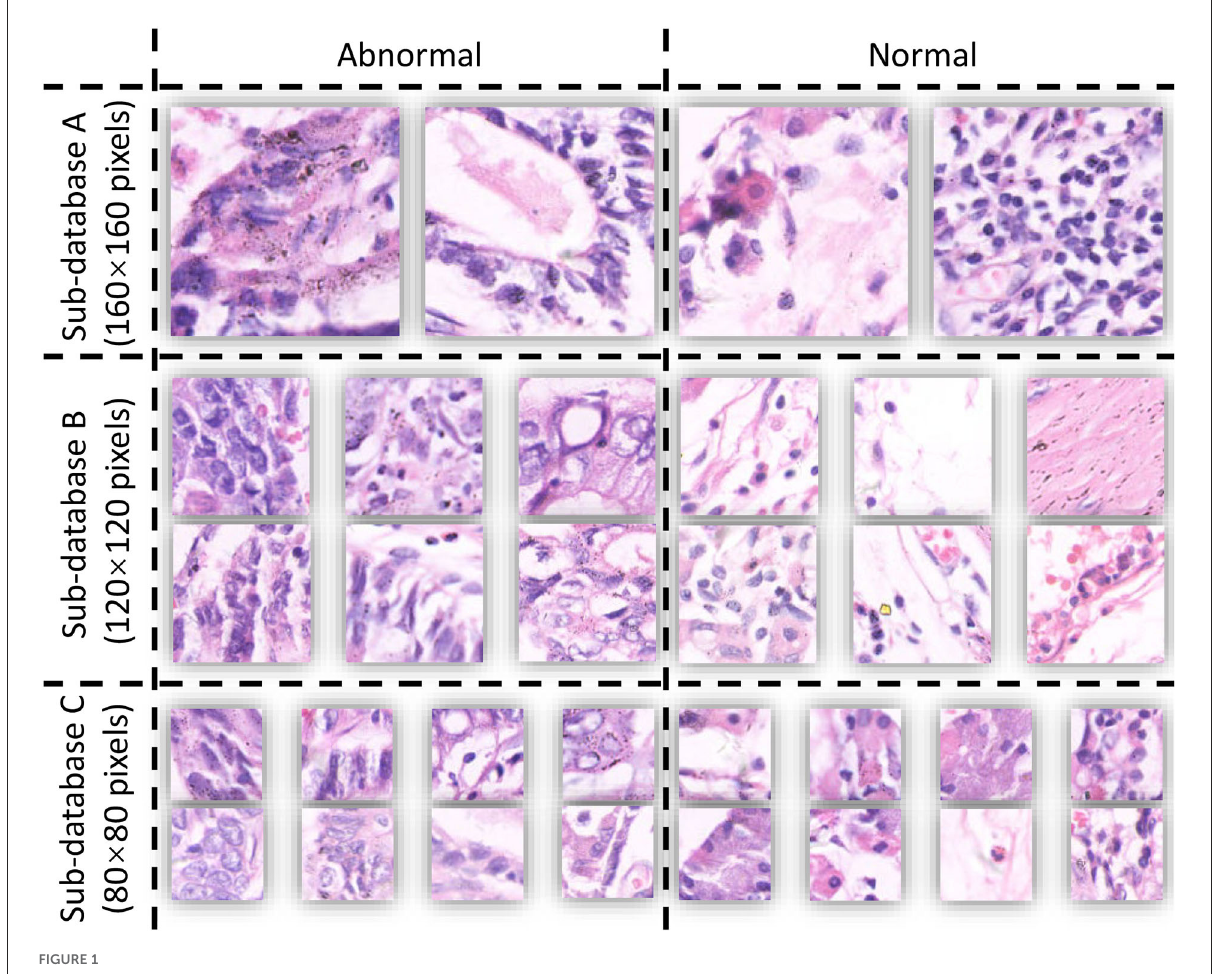
FIGURE1 Example of